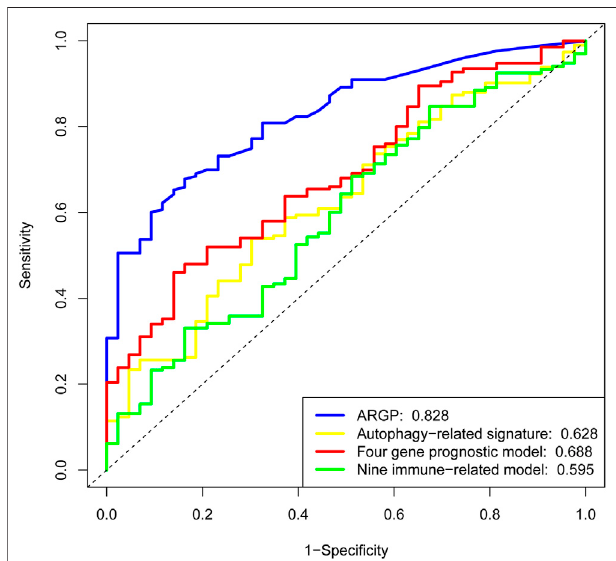
FIGURE 4 | Determination of the receiver operating characteristic (ROC) for different prognostic signatures. The AUC values for the ARGP model, Autophagy-related signature model, four prognostic lncRNA model, and nine immune-related model were 0.828, 0.628, 0.688, and 0.595, respectively. This result indicates that our signature possesses a higher predictive ef fi cacy and accuracy than the other